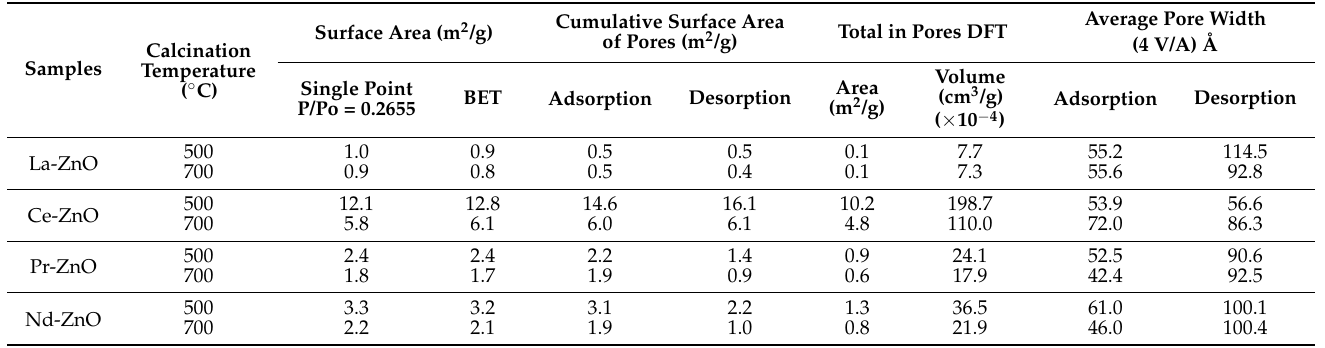
Table 3. Characteristics of M-ZnO (M = La 3+ , Ce 3+ , Pr 3+ and Nd 3+ ) nanoparticles calcined up to 500 ◦ C and 700 ◦ C.